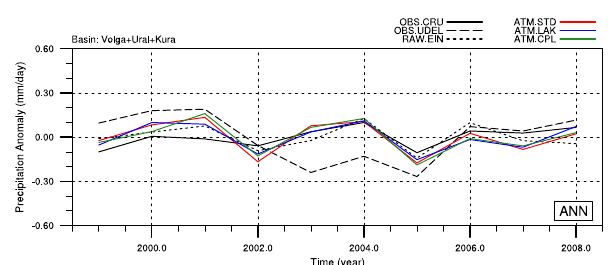
Fig. 7. Anomalies of annual precipitation (mmday − 1 ) for the pe- riod 1999–2008 in the model simulations and the different observa- tion datasets. The domain only includes the Volga, Kura and Ural basins shown in Fig. 3 (extracted from the Total Runoff Integrating Pathways, or TRIP,